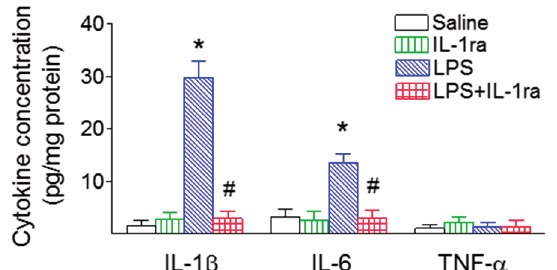
Figure 5. IL-1ra significantly attenuated induction of proinflammatory cytokines in the SN of P70 rat brain following LPS exposure. IL-1 β , IL-6 and TNF α concentrations were determined by ELISA, as described in the Methods section. The results are expressed as the mean ± SEM of six animals in the unit of pg/mg protein in each group, and analyzed by two-way ANOVA. * p < 0.05 represents significant difference for the LPS group as compared with the saline group. # p < 0.05 represents significant difference for the LPS+IL-1ra group as compared with the LPS